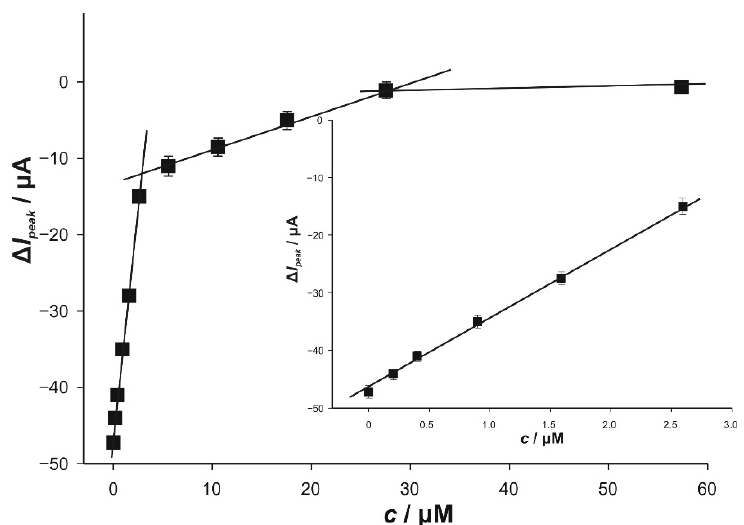
Figure 6. The calibration plot of the cathodic current peaks dependent on cysteine concentration (sequential addition of cysteine), derived from voltammograms presented in Figure 5. The inset represents the lower concentration range. For the plot, the five data value sets were used.